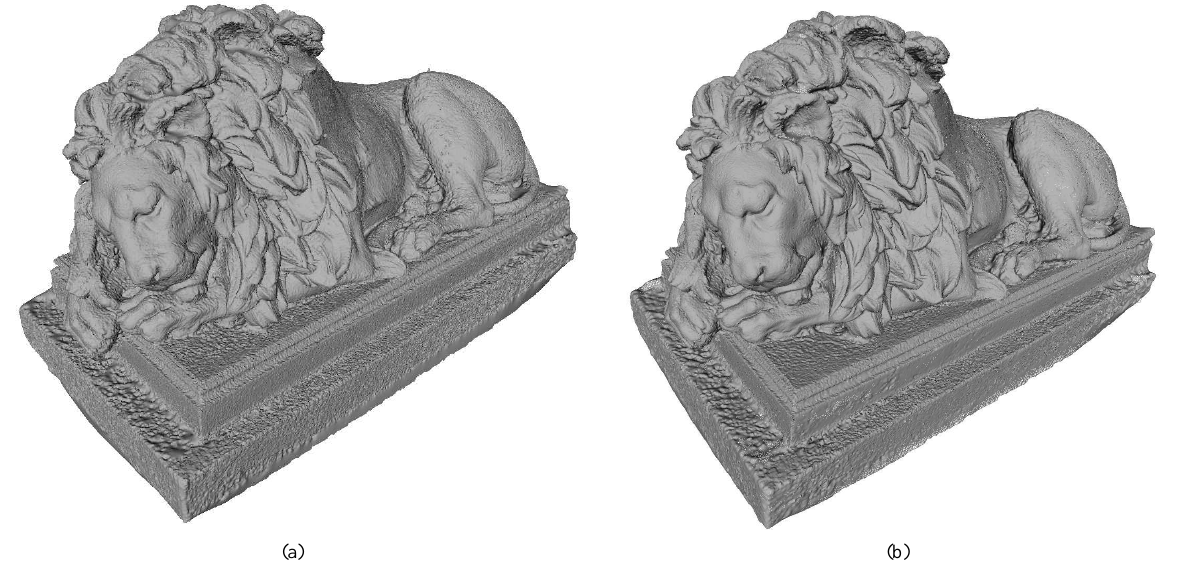
Figure 6: Poison reconstructions based on our oriented point sets. (a): RQT error threshold ǫ = 1 . 0 . (b): RQT error threshold ǫ = 1 .